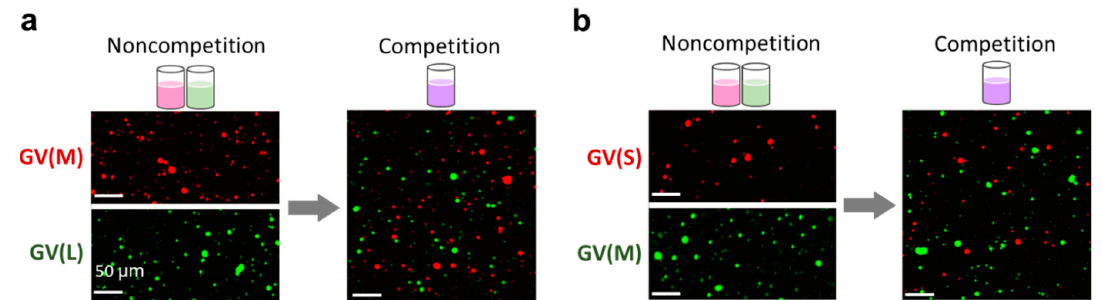
Figure 4. Competitive proliferation of GV-based artificial cells containing DNA (L 3,200, M 1,164, and S 374 bp). The increase ratios of GVs were measured by confocal scanning laser microscopy. For GV(L) vs. GV(M): GV(L) membrane was tagged with BODIPY-HPC, and GV(M) membrane was tagged with Texas Red-DHPE ( a ), and for GV(M) vs. GV(S): GV(M) membrane was tagged with BODIPY-HPC, and GV(S) membrane was tagged with Texas Red-DHPE ( b ). Table 1. Increase ratios of GV(L), GV(M), and GV(S) under noncompetitive condition. GV